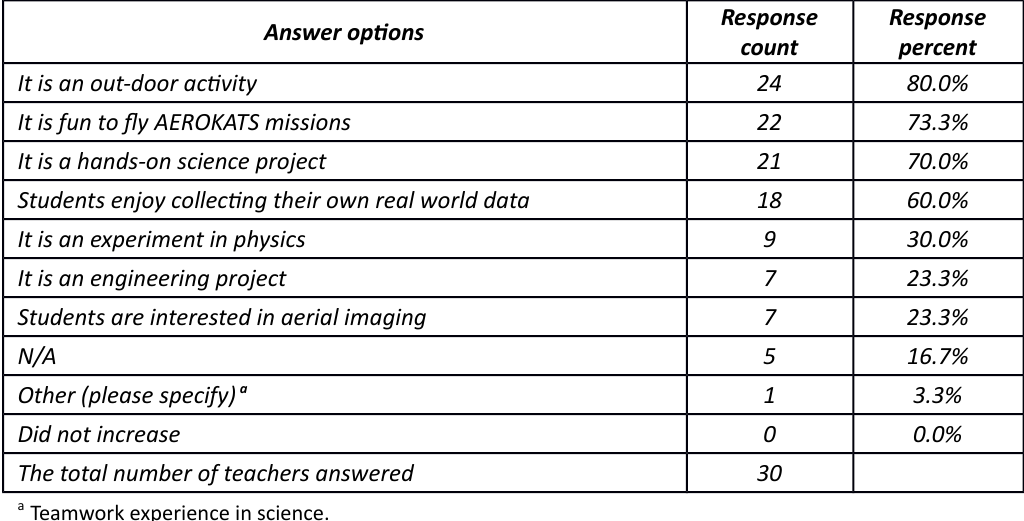
Table 8. The responses concerning the queston about the NASA AEROKATS remote sensing system The third survey instrument was the pre- and post-ICCARS student exams of the same 22 questons. The exam questons were adapted from ‘A Mater of Degree’, created by KQED Public Broadcastng, (2013) and based on a 2009 analysis of a natonally representatve study of 2,164 American adults conducted in the fall of 2008,